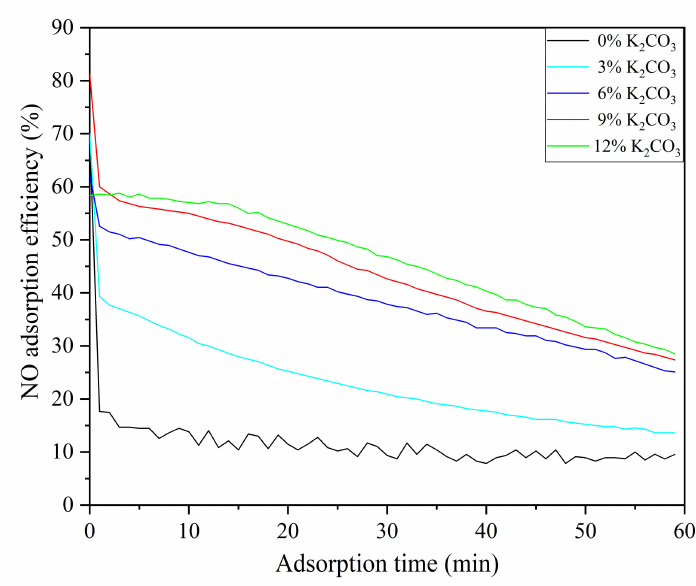
Figure 5. Effect of modified activated coke with different K 2 CO 3 concentrations on NO adsorp- tion